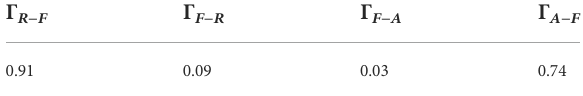
TABLE 2 Transition probabilities for μ M-C obtained through geometrical reasoning and system identi fi cation.